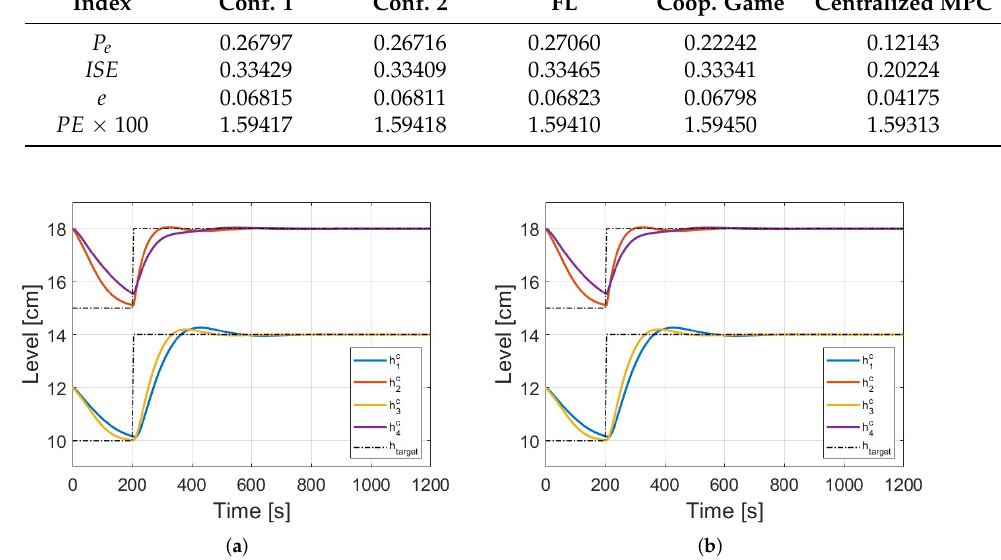
Figure 8. Validation Case 3: Evolution of the levels of the controlled variables involving steps: ( a ) Conf. 1 performance; ( b ) Conf. 2